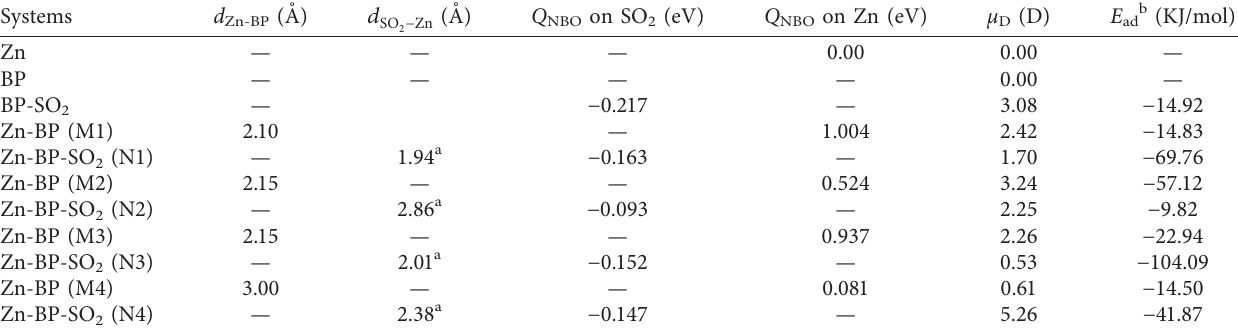
Figure 3: (a) SO 2 -adsorbed B 12 P 12 and SO 2 -adsorbed Zn-doped B 12 P 12 systems: (b) N1, (c) N2, (d) N3, and (e) N4. Table 1: The closest distance of SO 2 to BP, Zn metal to pure BP, Q NBO (Charge) on metal and gas, dipole moment, and adsorption energies of different